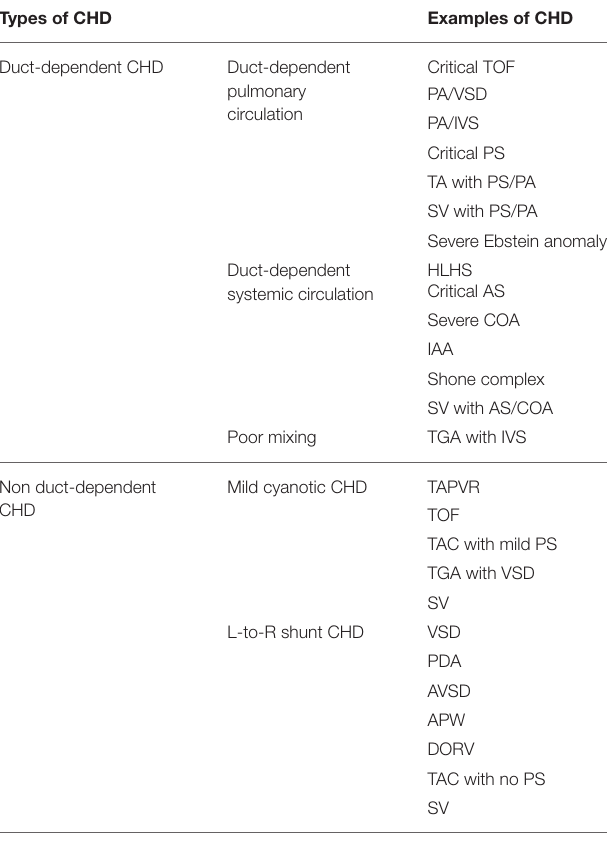
TABLE 1 | Classification of the congenital heart defects according to the post-natal adaptation. Types of